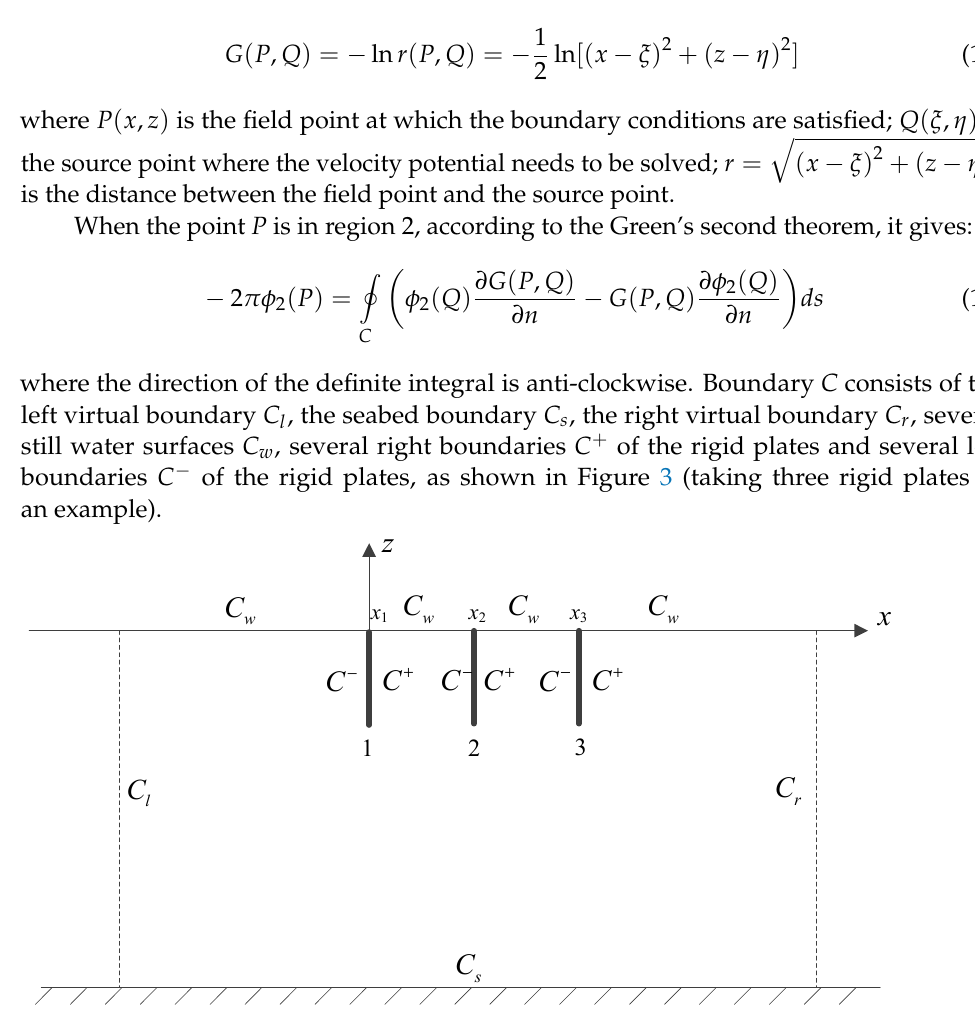
Figure 3. Diagram of boundary division.